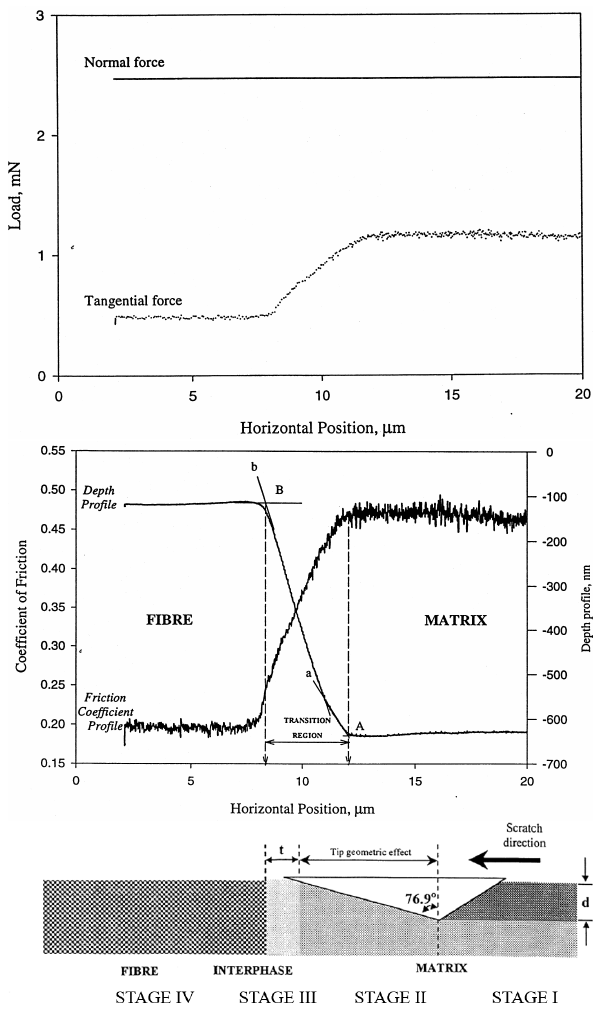
Figure 5: Schematic analysis of results of evaluation of interface characteristics by nanoscratch test. (a) Normal and tangential force profile. (b) Coeflcient of friction and scratch depth profiles. (c) Schematic illustrations of nanoscratch depth profiles at different stages